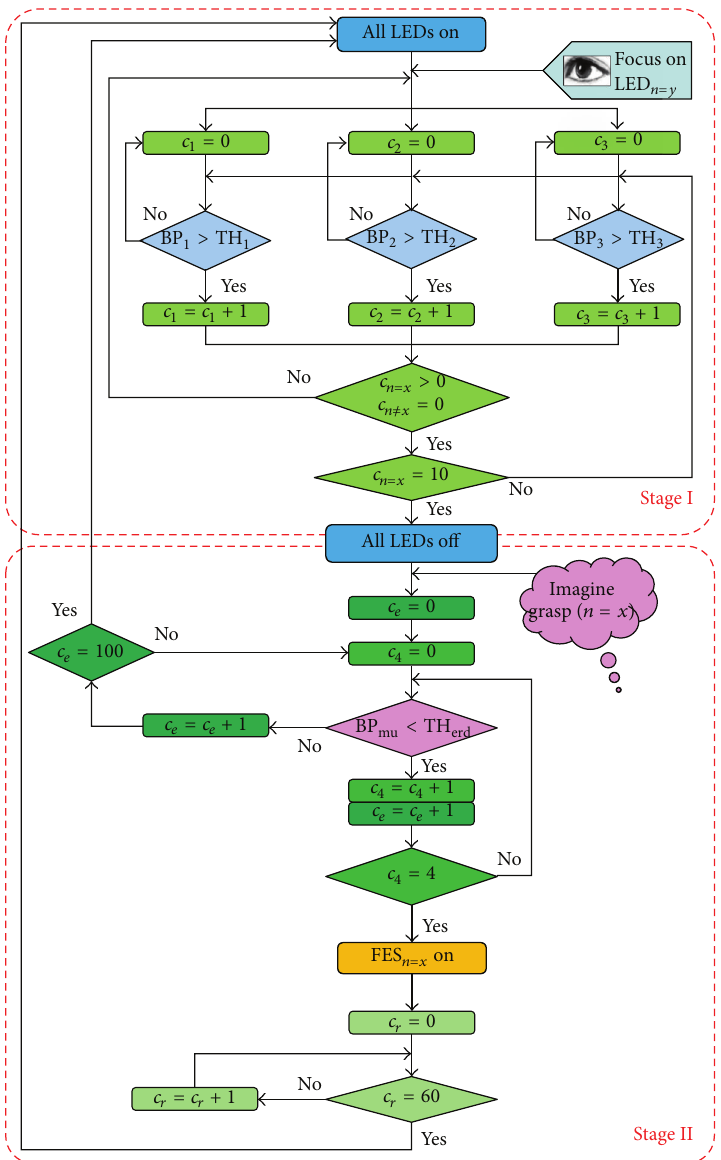
Figure 3: The workflow of the two-stage hybrid BCI operation. LED 𝑛 ( 𝑛 = 1 –3) stands for LED beside the cup, CD case, and playing cube, respectively. LED 𝑛=𝑦 is chosen by the subject for visual focusing. If 𝑥 = 𝑦 at the beginning of stage II (all LEDs off), then the correct SSVEP was detected. FES 𝑛 are the FES patterns for induction of palmar, lateral, and precision grasp, respectively. FES 𝑛=𝑥 is the stimulation pattern adequateforgraspingoftheobjectbesideLED 𝑛=𝑥 .Thecounters 𝑐 1 , 𝑐 2 , 𝑐 3 , 𝑐 4 , 𝑐 𝑒 ,and 𝑐 𝑟 computethenumberofconsecutivewindows(iterations). The 𝑐 1 , 𝑐 2 ,and 𝑐 3 measuretheDT 𝑠 forBP 1 ,BP 2 ,andBP 3 ,respectively.The 𝑐 4 measurestheDT erd .The 𝑐 𝑒